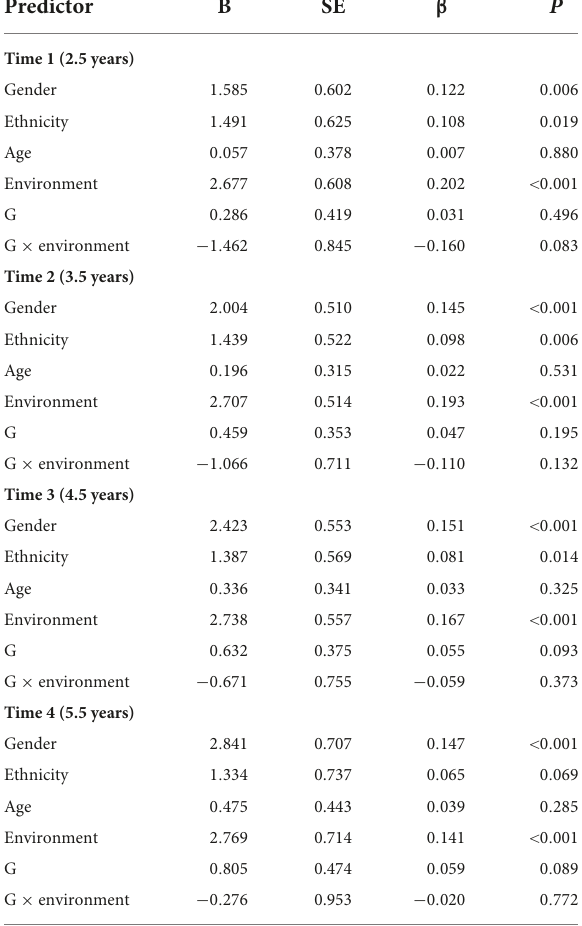
TABLE 3 Main and gene–environment interaction effects of rs2267735 on the course of posttraumatic stress disorder symptoms at 2.5, 3.5, 4.5, and 5.5 years after the earthquake (across all